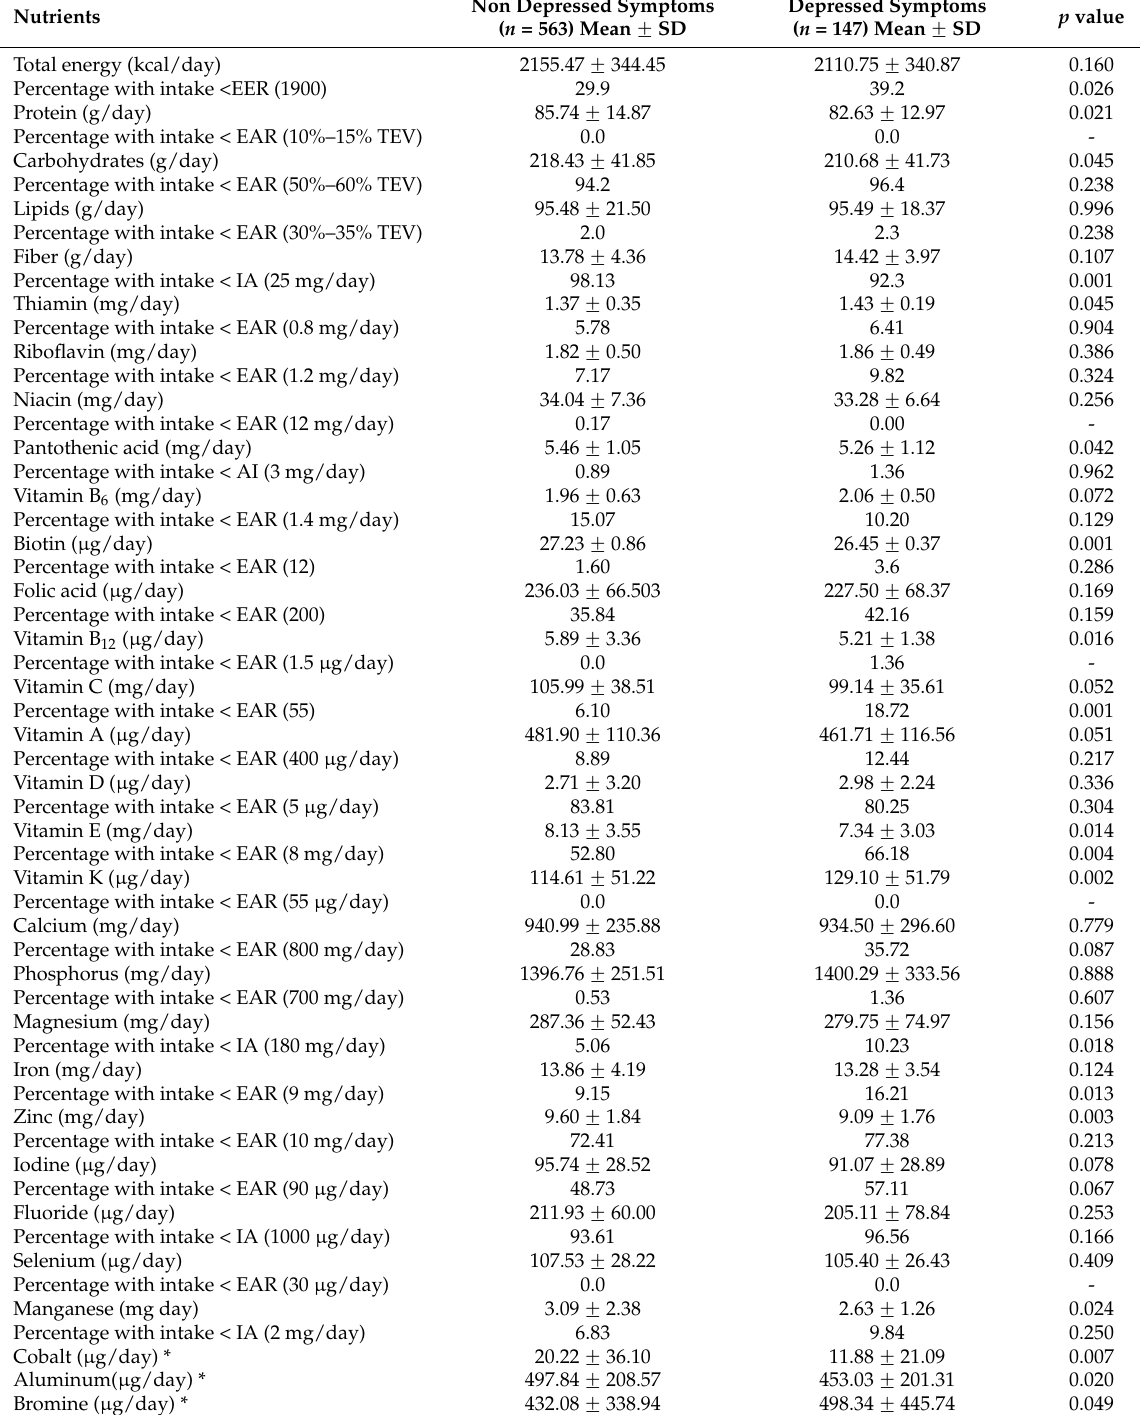
Non Depressed Symptoms ( n = 563) Mean ˘ SD